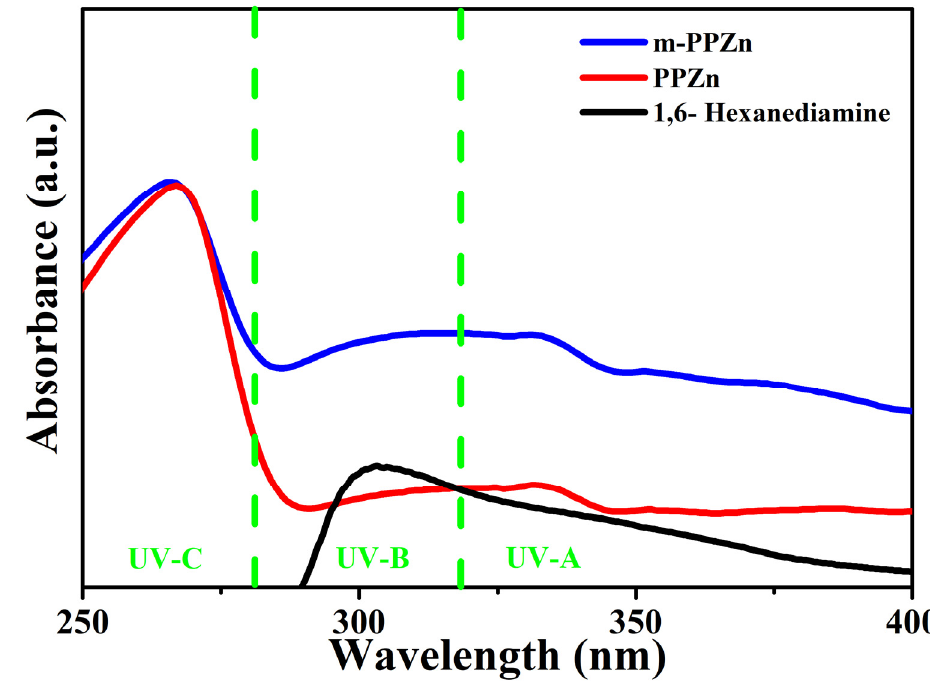
Figure 2. UV-Vis absorbance spectra of the PPZn, 1,6-hexanediamine and m-PPZn. The green lines in this figure illustrate the UV-A, UV-B, and UV-C